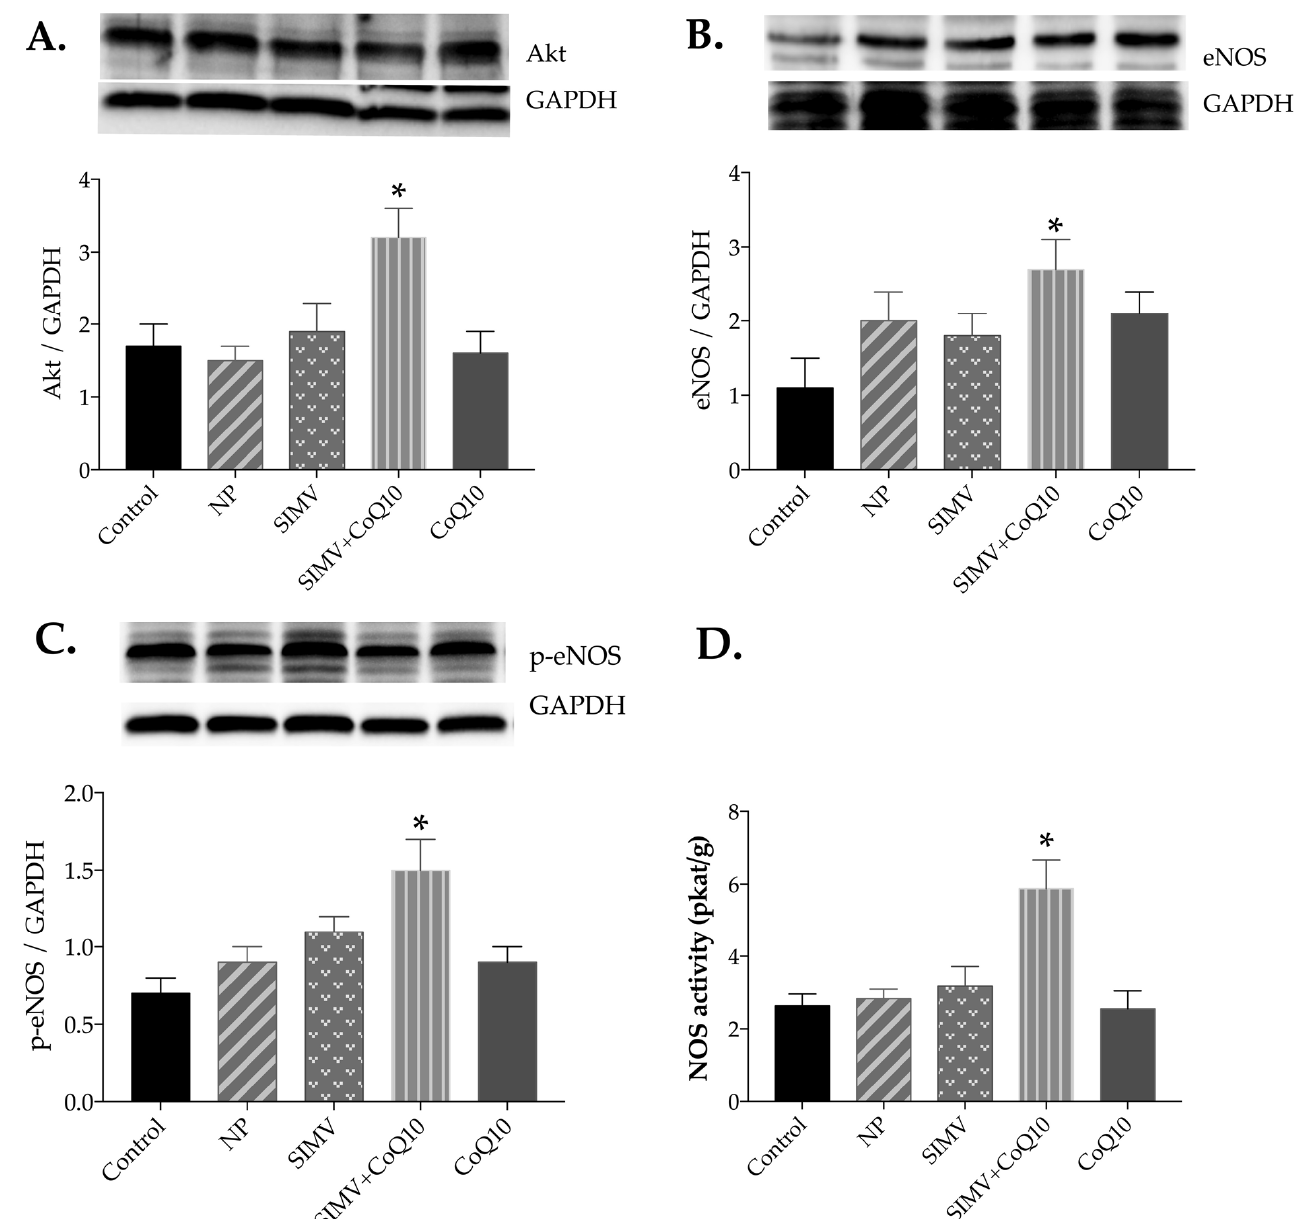
Figure 2. Expression levels and representative Western blot images of Akt ( A ), endothelial nitric oxide synthase (eNOS) ( B ), phosphorylated eNOS (p-eNOS) ( C ), and total NOS activity ( D ) in the heart of the control group and groups treated with empty nanoparticles (NP), simvastatin-loaded nanoparticles (SIMV), combination of simvastatin-loaded and coenzyme-Q10-loaded nanoparticles (SIMV+CoQ10), and coenzyme-Q10-loaded nanoparticles (CoQ10). * p < 0.05 compared to the control obese Zucker rats. Data are means ± SEM from 6 animals in each group.